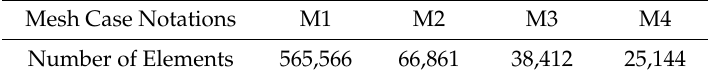
Table 1. Mesh sizes for the purpose of grid convergence.